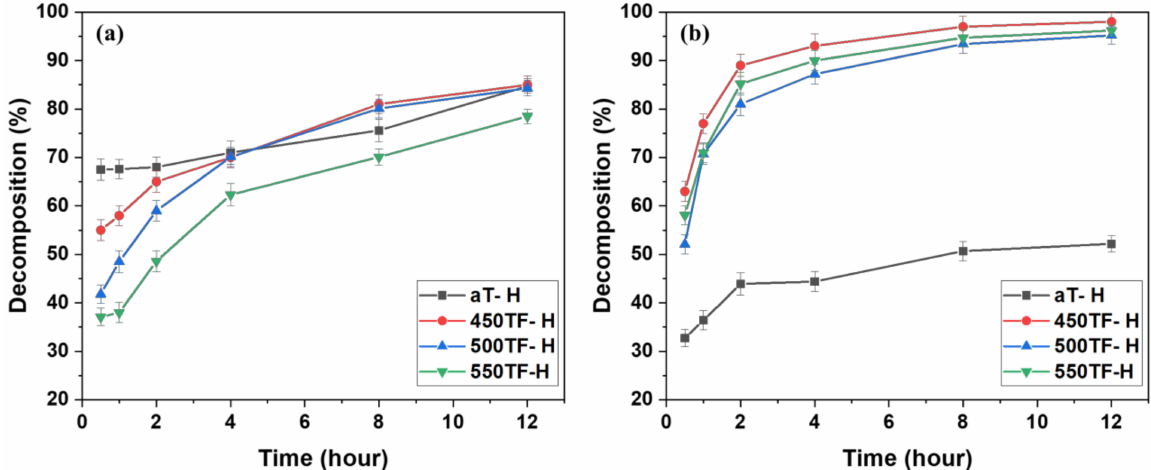
Figure 8. Photocatalytic self-cleaning properties of the photocatalyst/HDS-treated PET fabrics; under ( a ) UV and ( b )